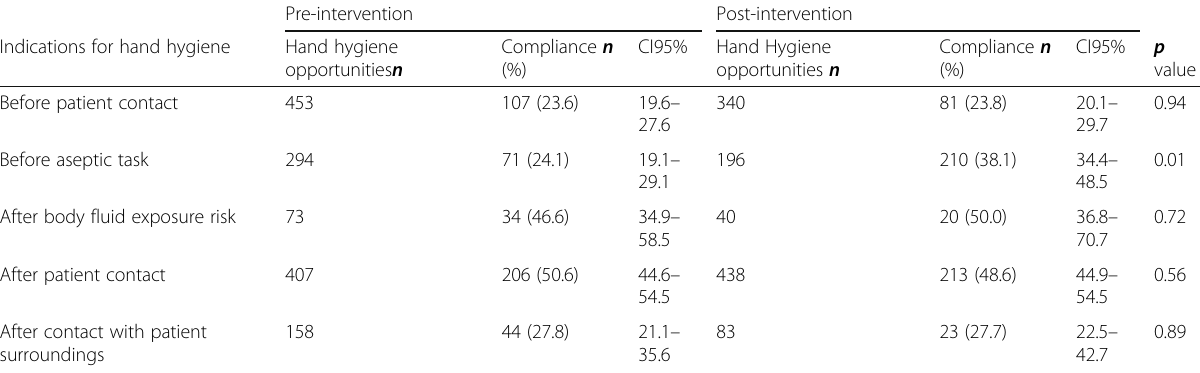
Table 2 Hand hygiene compliance according to the WHO 5 indications, before and after intervention, at University Hospital Sahloul, Sousse, Tunisia 2015 – 2016 Pre-intervention